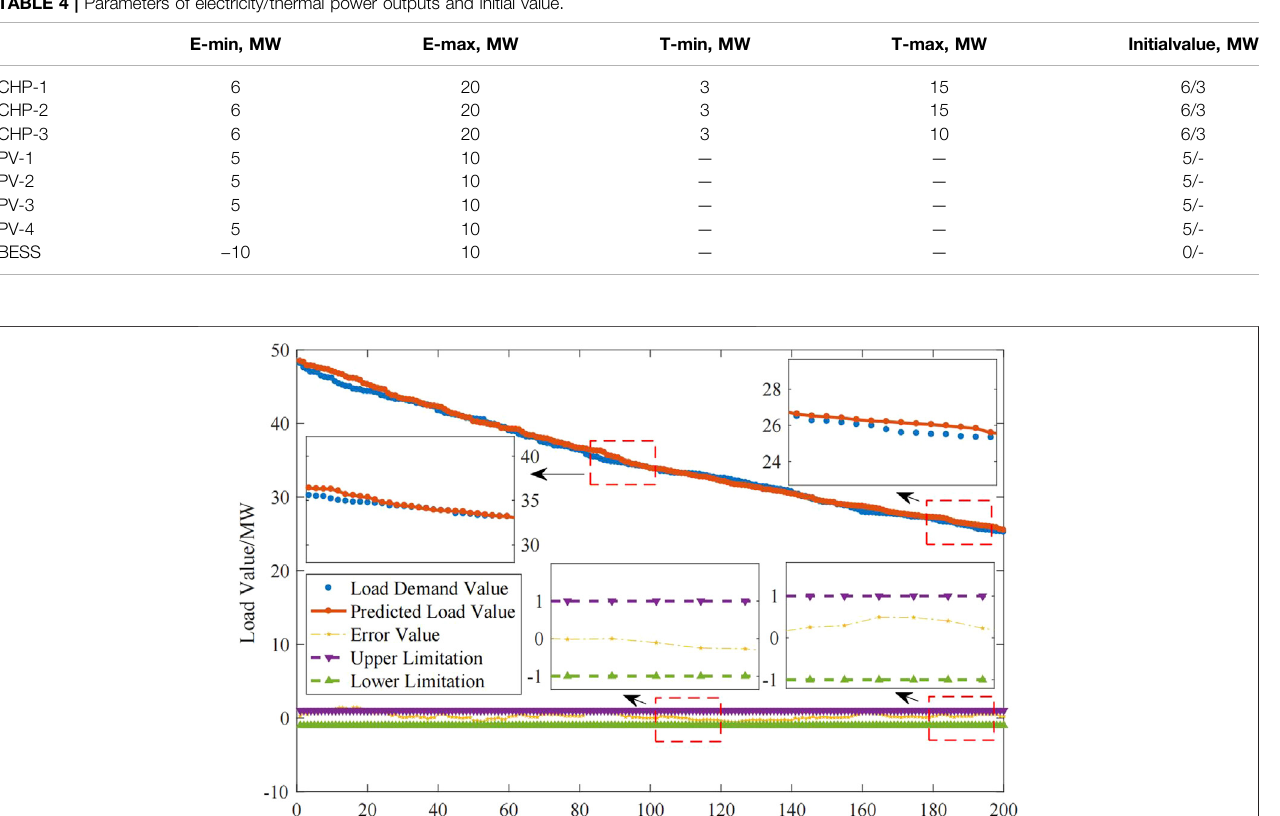
TABLE 4 | Parameters of electricity/thermal power outputs and initial value.